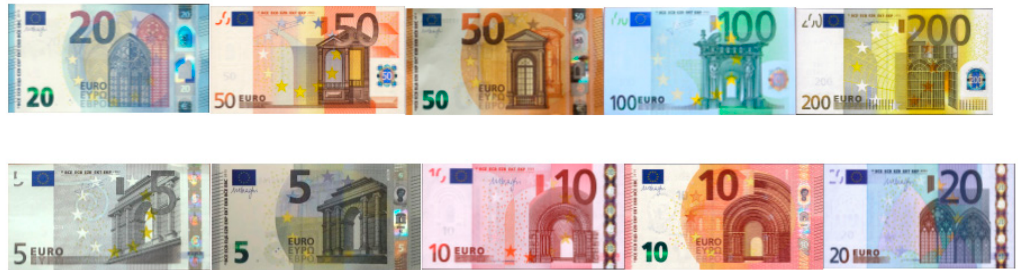
Figure 4. Positive samples: Pictures taken from real Euro banknotes, both old and new issue.